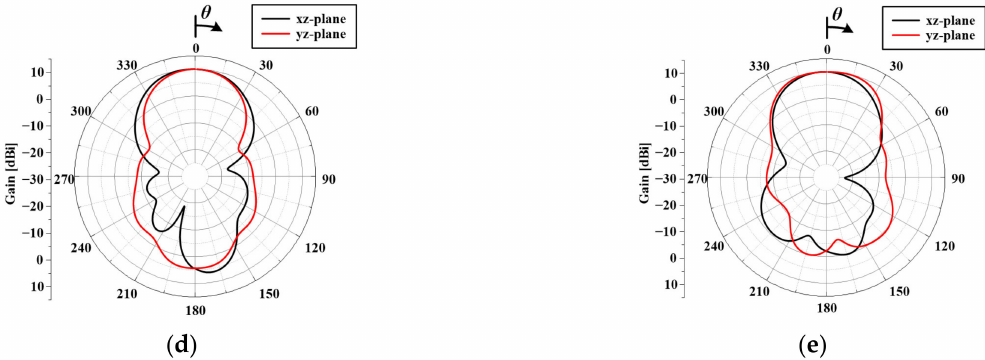
Figure 4. 2 × 2 patch antenna array with feeding network: ( a ) geometry of antenna array, ( b ) perspective view, ( c ) simulated S-parameters, ( d ) simulated radiation patterns at 35 GHz when Port 1 is excited, and ( e ) simulated radiation patterns at 35 GHz when Port 2 is excited.